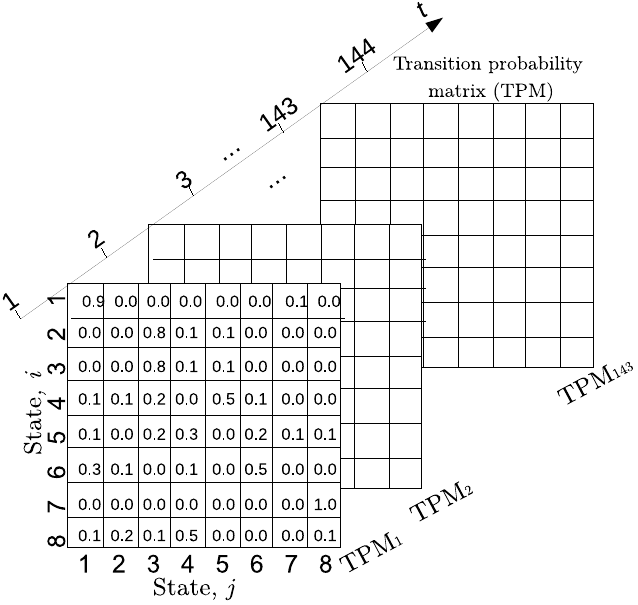
Figure 3. The transition probability matrix in the Markov